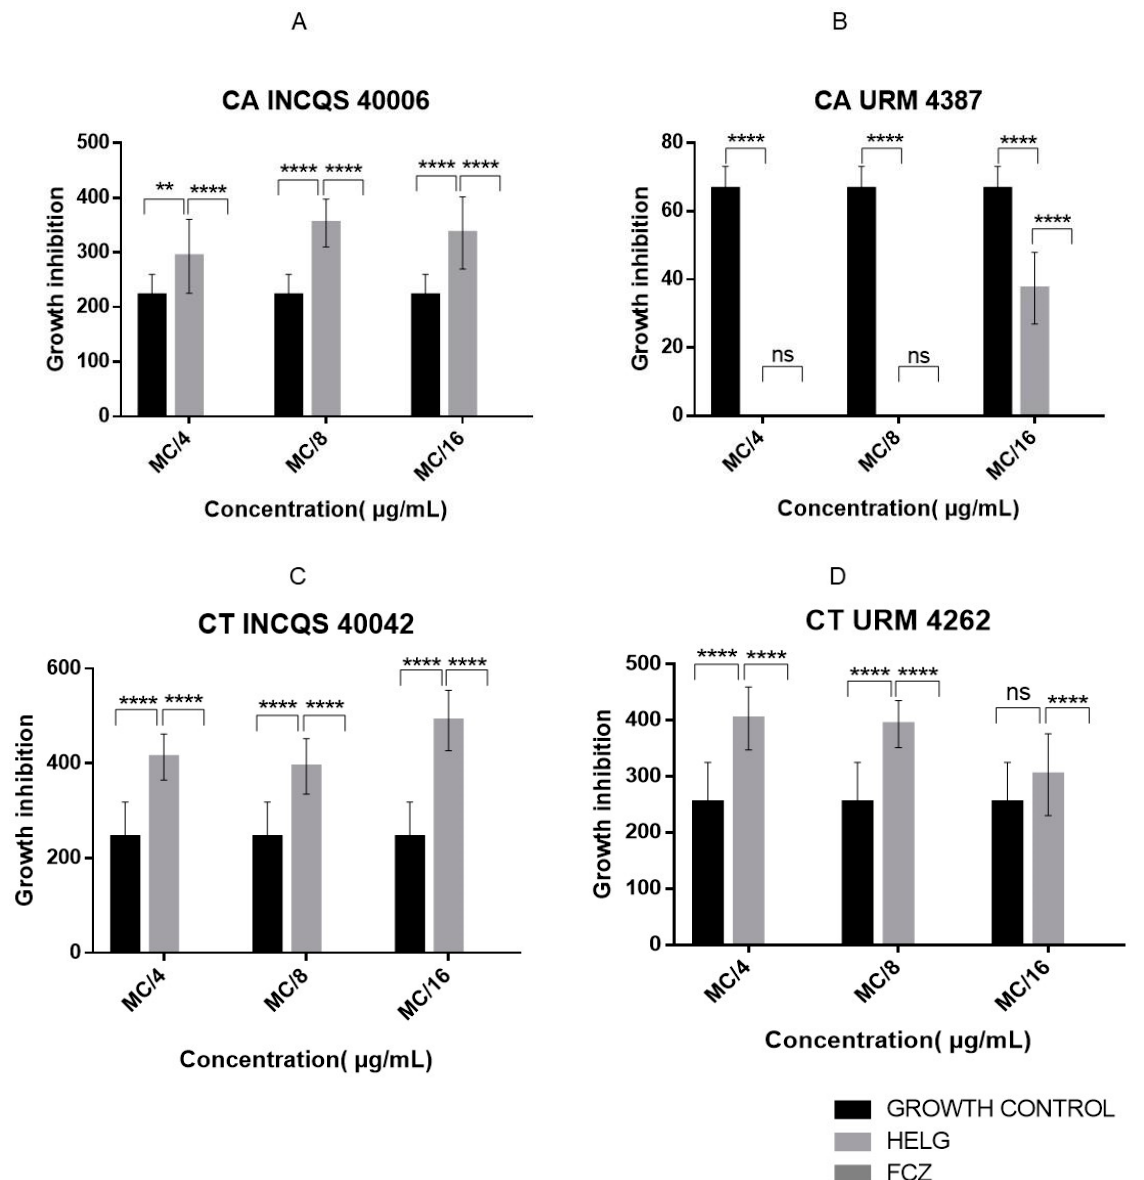
Figure 7. Effects of G. hirsutum hydroethanolic extract and fluconazole on the morphological transition of Candida albicans INCQS 40006 ( A ), Candida albicans URM 4387 ( B ), Candida tropicalis INCQS 40042 ( C ) and Candida tropicalis URM 4262 ( D ). MC: Matrix Concentration (16.384 μ g/mL); MC/4: 4.096 μ g/mL, MC/8: 2.048 μ g/mL, MC/16: 1.024 μ g/mL; Growth inhibition—measured by microme ‐